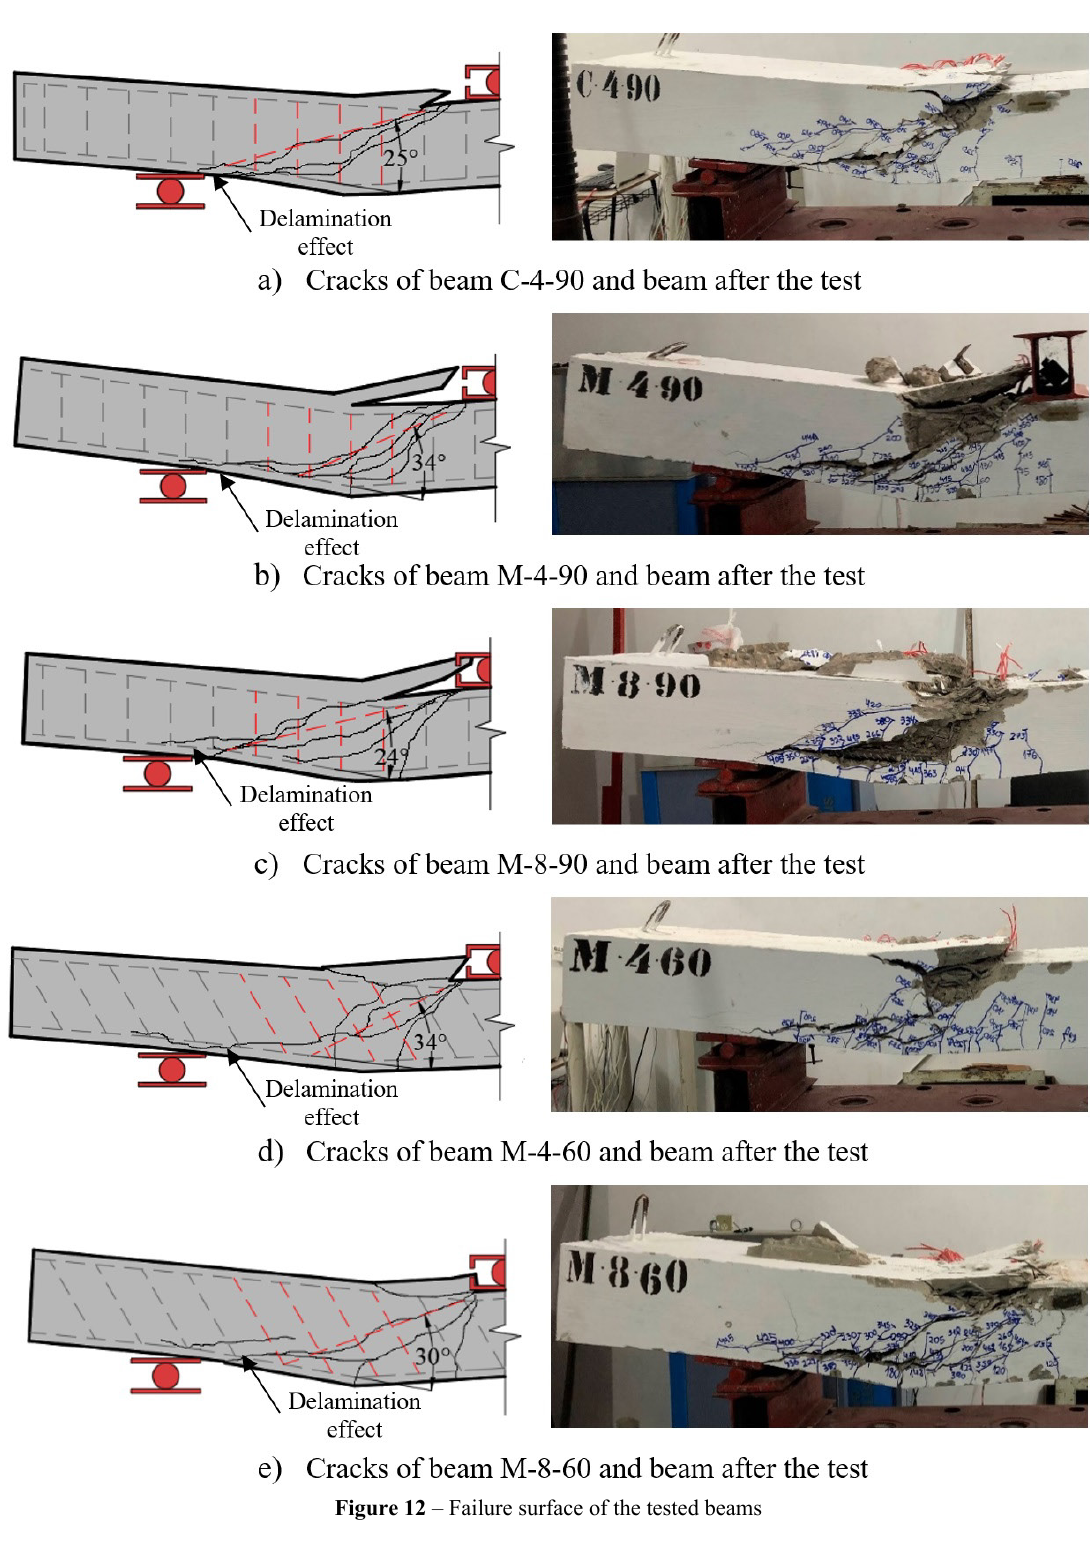
Figure 12 – Failure surface of the tested